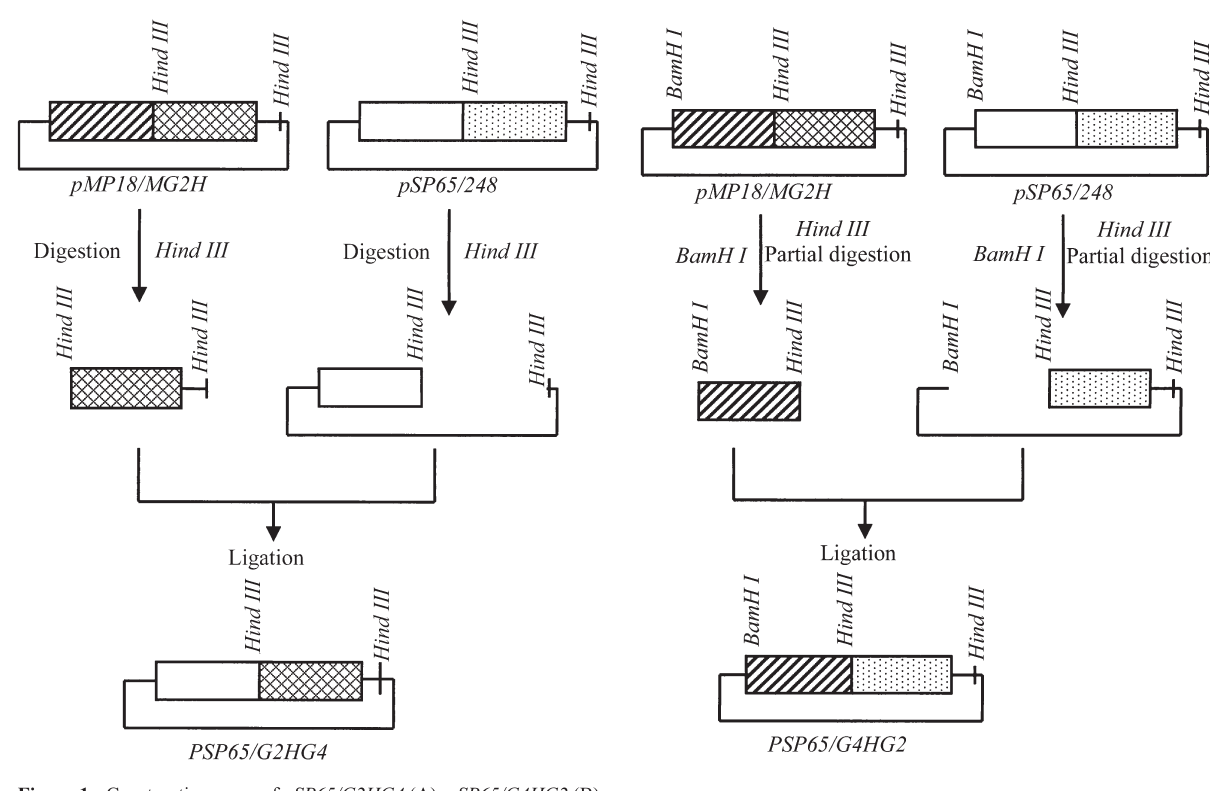
Figure 1 - Construction maps of pSP65/G2HG4 (A), pSP65/G4HG2 (B).